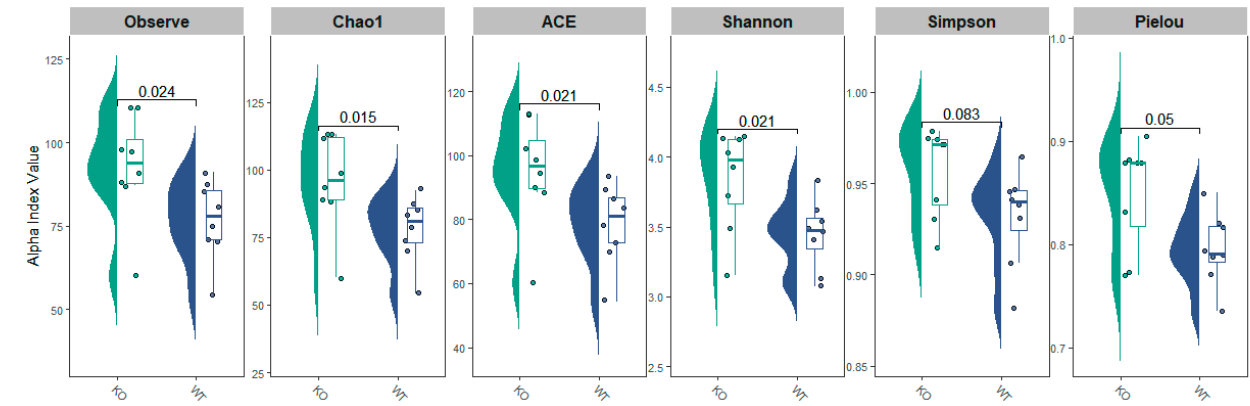
Figure 2. α -diversity among wild-type (WT) and TAAR9-knock out (KO) rats. α -diversity, measured by observed species, Chao1, abundance-based coverage estimator (ACE), Shannon, Simpson, and Pielou results are plotted for examined samples. Box plots and violin plots depict microbiome diversity and abundance differences according to each test. The horizontal line inside the box represents the median. Individual sample values are represented by dots.